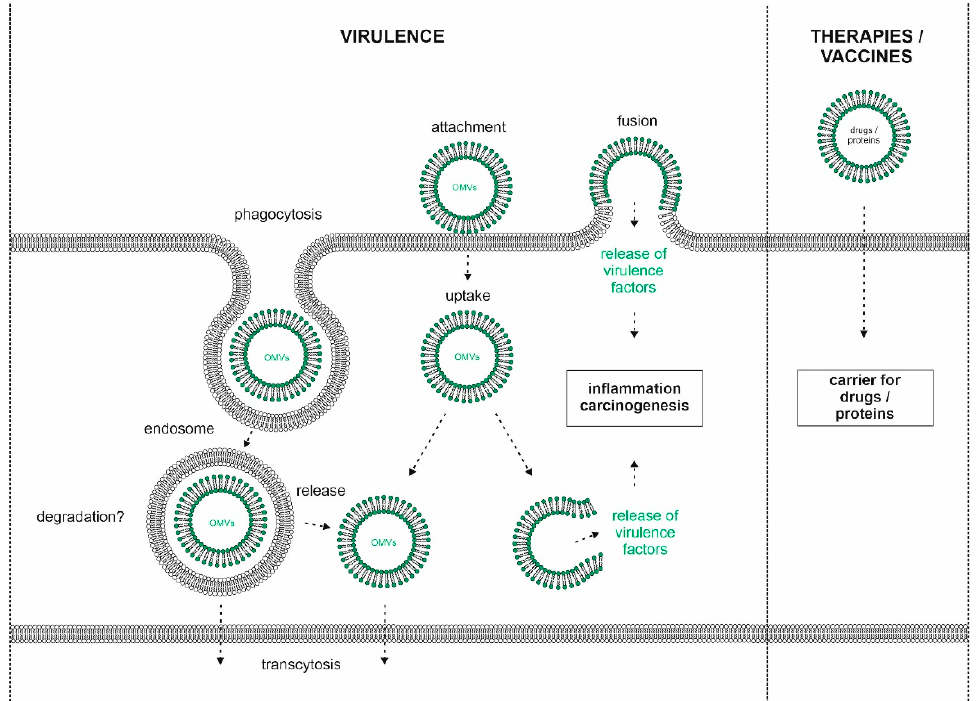
Figure 2. Model of OMV interaction with host cells. H. pylori releases OMVs, which attach to the cell surface of gastric epithelial cells. Clathrin-dependent and -independent uptake of OMVs could occur via phagocytosis leading to the formation of endosomes and/or fusion of the bacterial OMV membrane with the host´s membrane. The fate of internalized OMVs is unclear, but the release of OMVs at the basolateral membrane (transcytosis) or into the cytoplasm was hypothesized. OMV-delivered virulence factors might be released into the cytosol where they can interfere with host cell signaling leading to inflammation and carcinogenesis (left panel). Technical applications of H. pylori OMVs as nanocarriers for drugs or proteins (right panel).